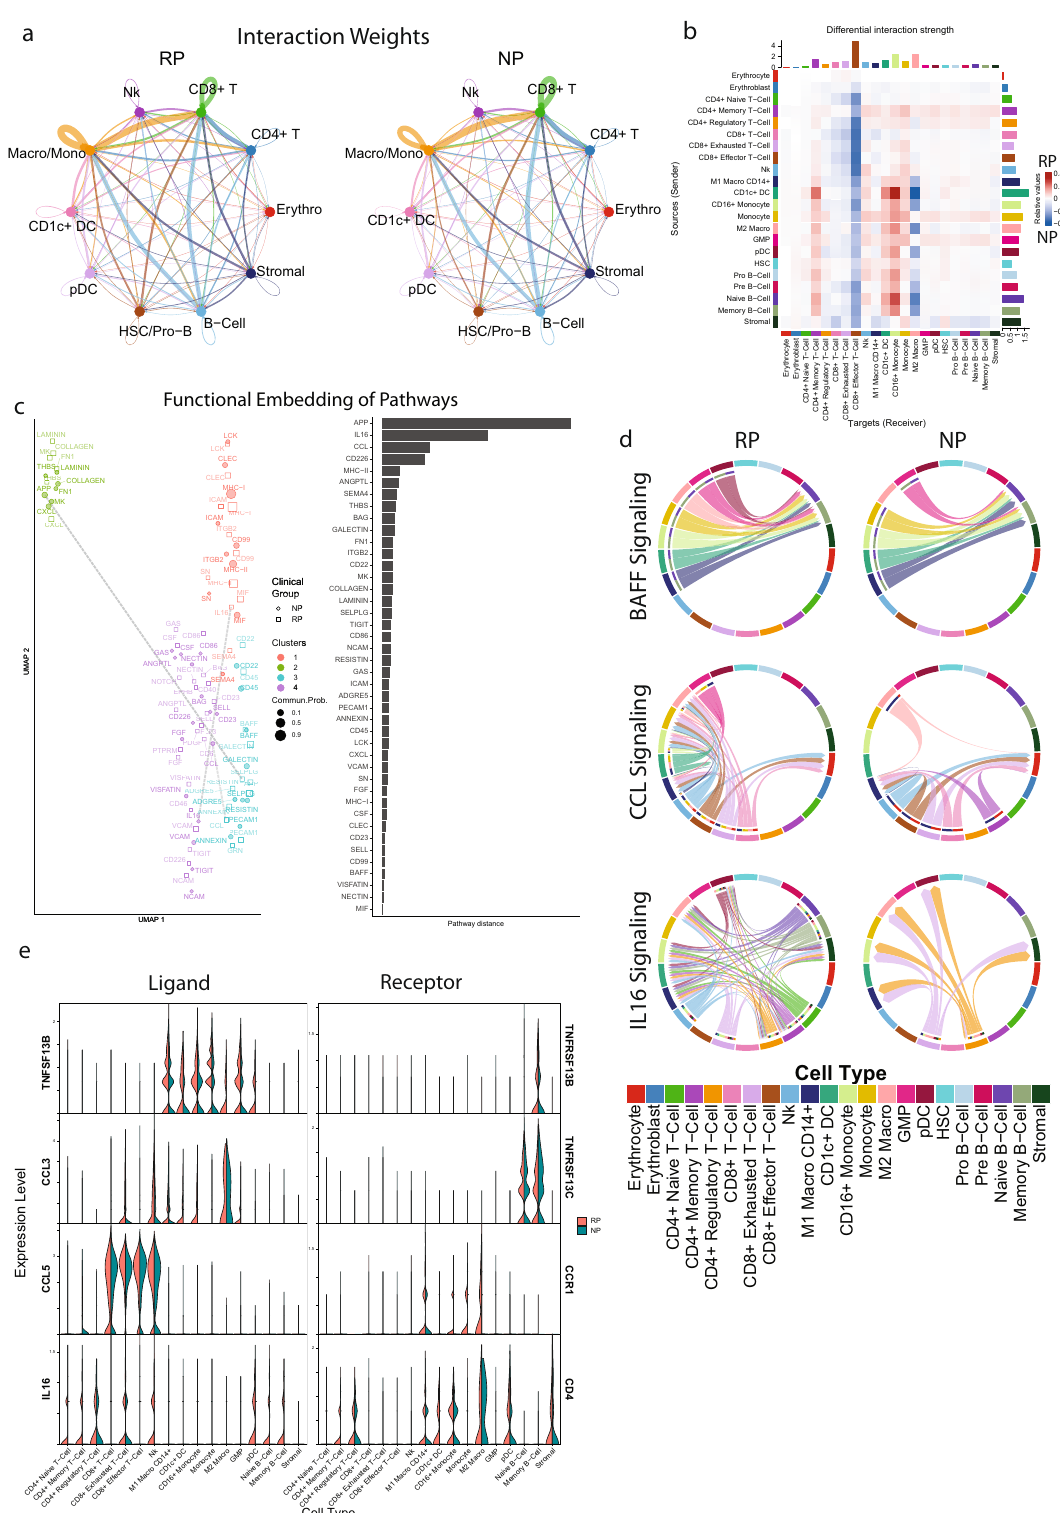
the relative cell abundance changed, with frozen samples tending to have higher mitochondrial transcripts 39 . This study demon- strates the feasibility of integrating single-cell pro fi ling data generated in multi-center national and international clinical trials with minimal technical